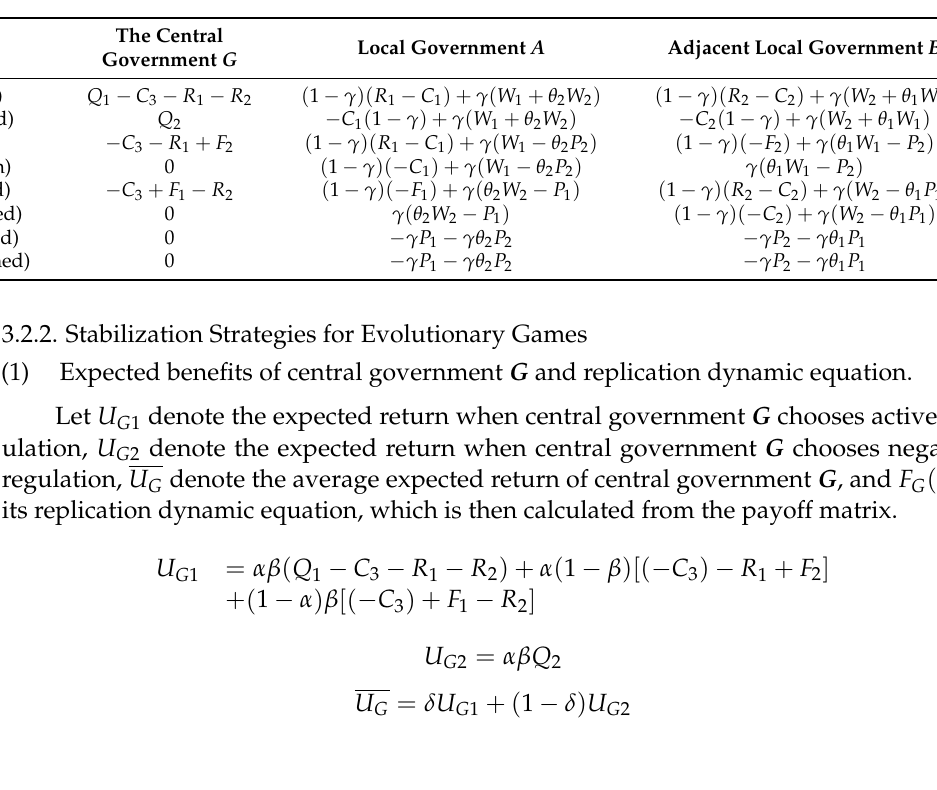
Table 2. Strategy combinations and payoff matrix of the participants of the three-party